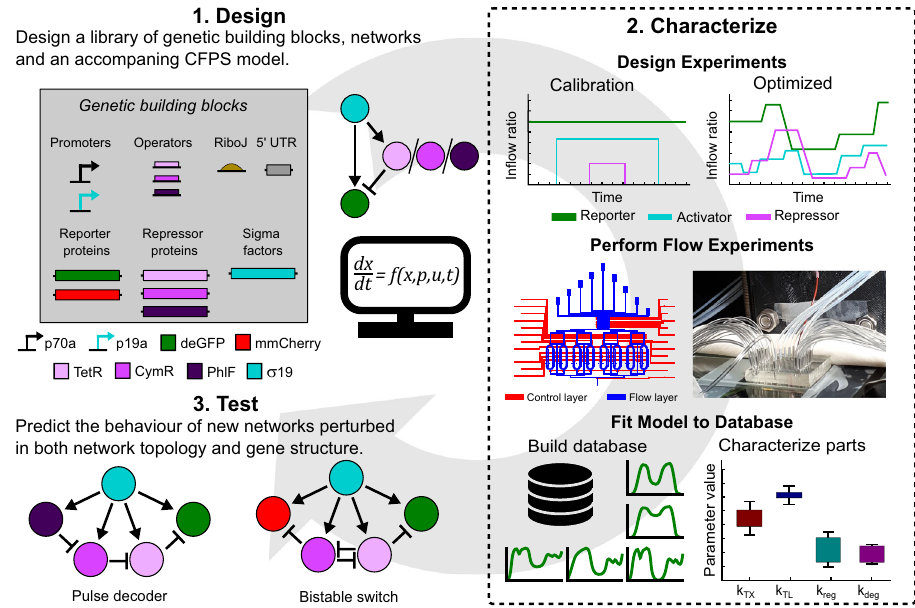
Fig. 1 Overview of the design – characterize – test pipeline. (1) IFFLs are assembled from a library of genetic building blocks. All IFFLs share the same activator but differ in the repressors. Detailed gene structures and names are provided in Fig. 2. Besides, a CFPS ODE model is formulated to describe all reactions (Eqs. 3 – 9 in the Supplementary Information). (2) Calibration and optimized in fl ow patterns are created (top) and used to perform CFPS experiments in micro fl uidic chemostats (middle). Schematic representation of the micro fl uidic device (left) and a picture of a single device plugged in and ready for an experiment (right) are shown. All experiments are combined in a database and we estimate the parameter values and distributions using the associated kinetic models. (3) Using the same library of building blocks, two new networks are assembled and are used as test cases to assess the predictive power of the estimated parameters and model. General overview of the network topology is shown. Detailed gene structures and names are provided in Figs. 4 and